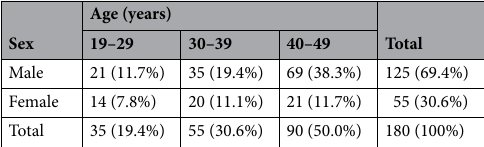
Table 3. Age distribution of